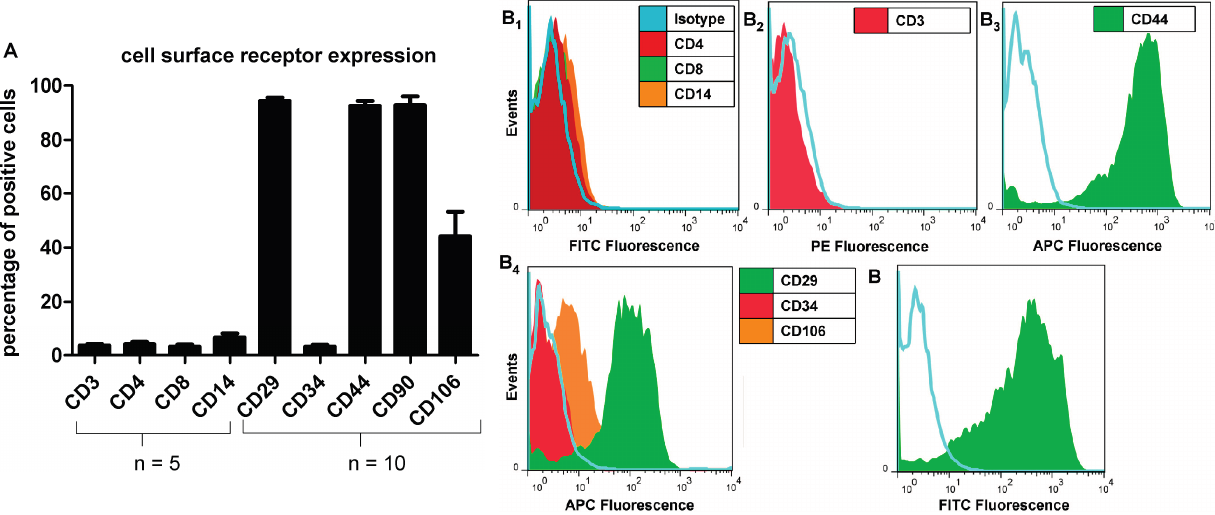
Figure 1. Characterization of mesenchymal stromal cells (MSCs) surface marker expression (passages 4–6) using flow cytometry. The isolated and adherent MSCs (cultured